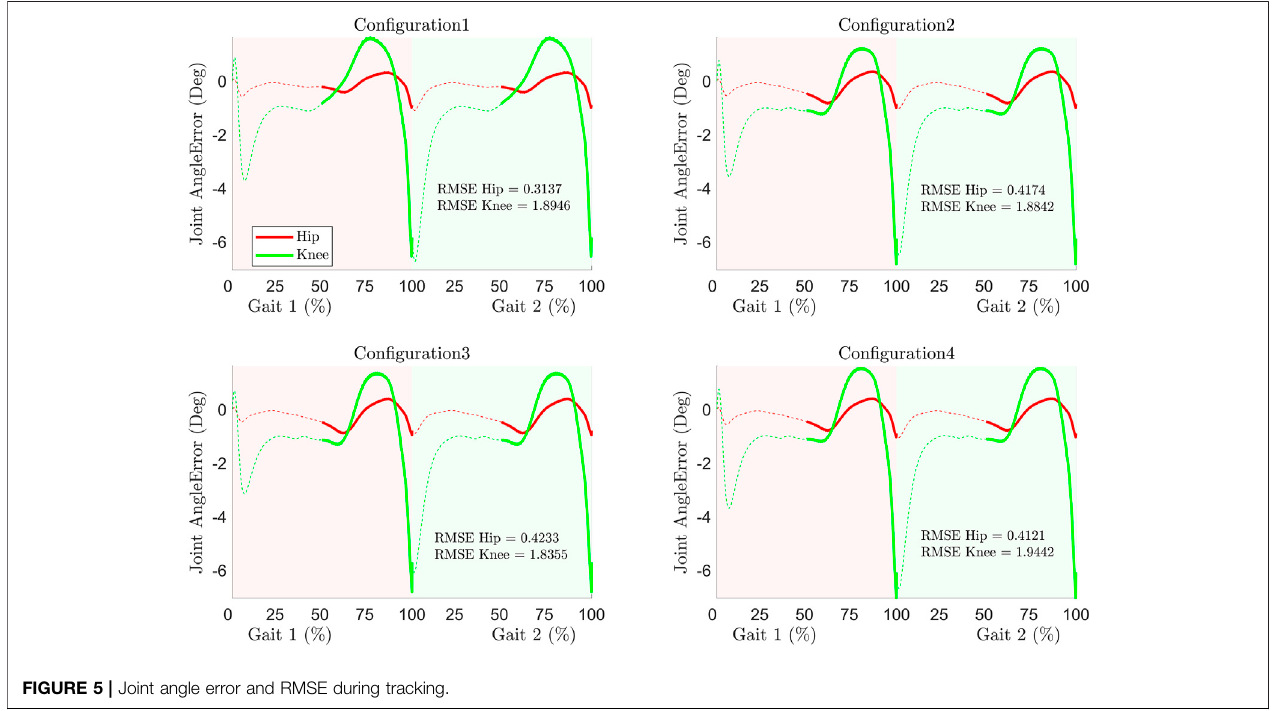
FIGURE 5 | Joint angle error and RMSE during